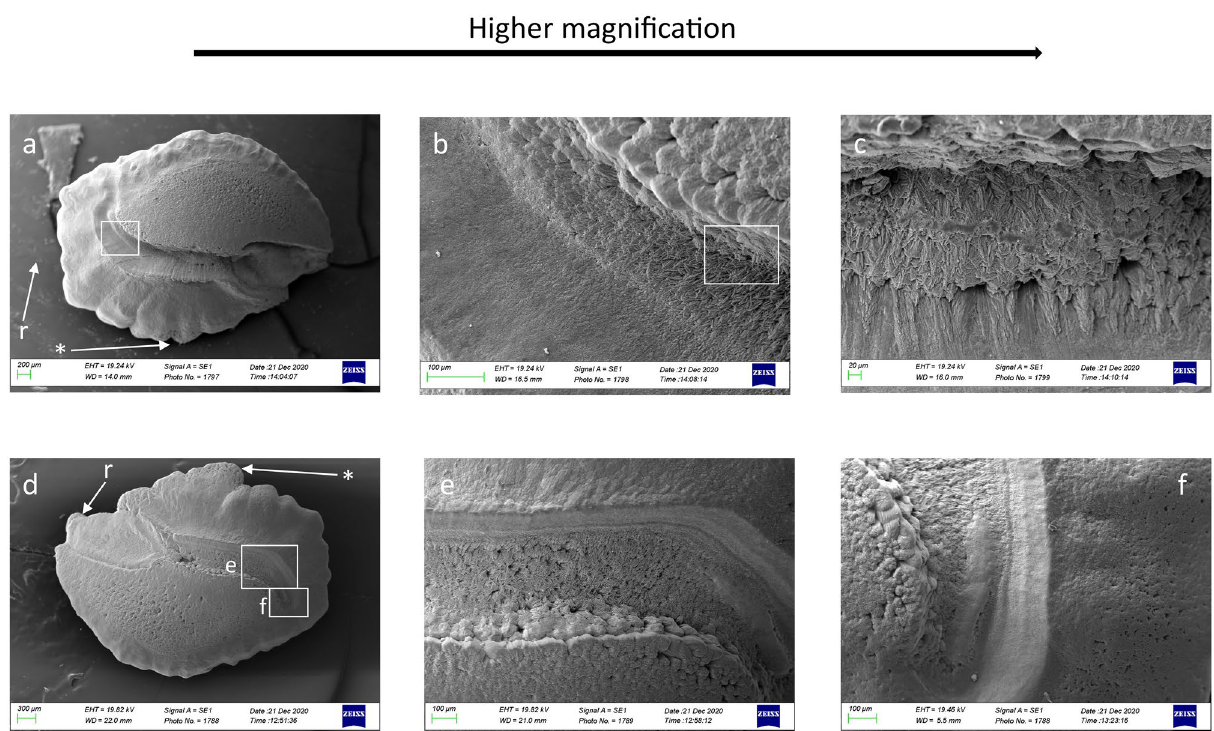
Figure 3. SEM images of the proximal surface of P. erythrinus : adults ( d ) and juveniles ( a ) otoliths left sagittae, with details of sulcus acusticus ( b , c , e , f ). (r) indicates the rostrum and (*) indicates the dorsal